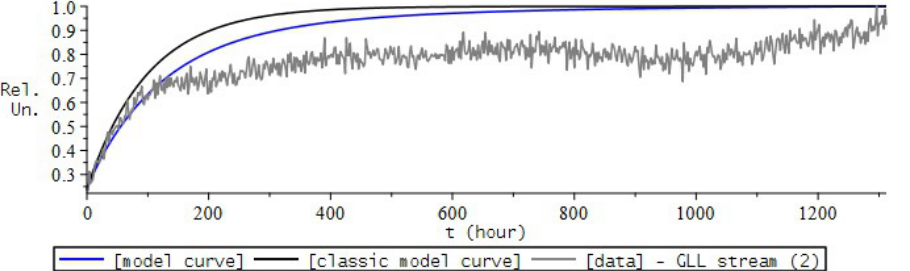
Figure 29. Correlation coefficients: 92% for the proposed (17) model (blue), and 90% for the classic (15) model (black).